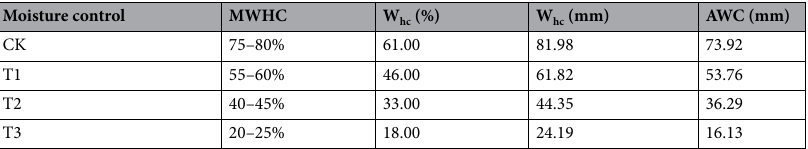
Table 1. Test soil moisture content information. The average soil water content was obtained from several random samples (n = 5). MWHC, maximum water-holding capacity; W hc , soil water-holding capacity; AWC,